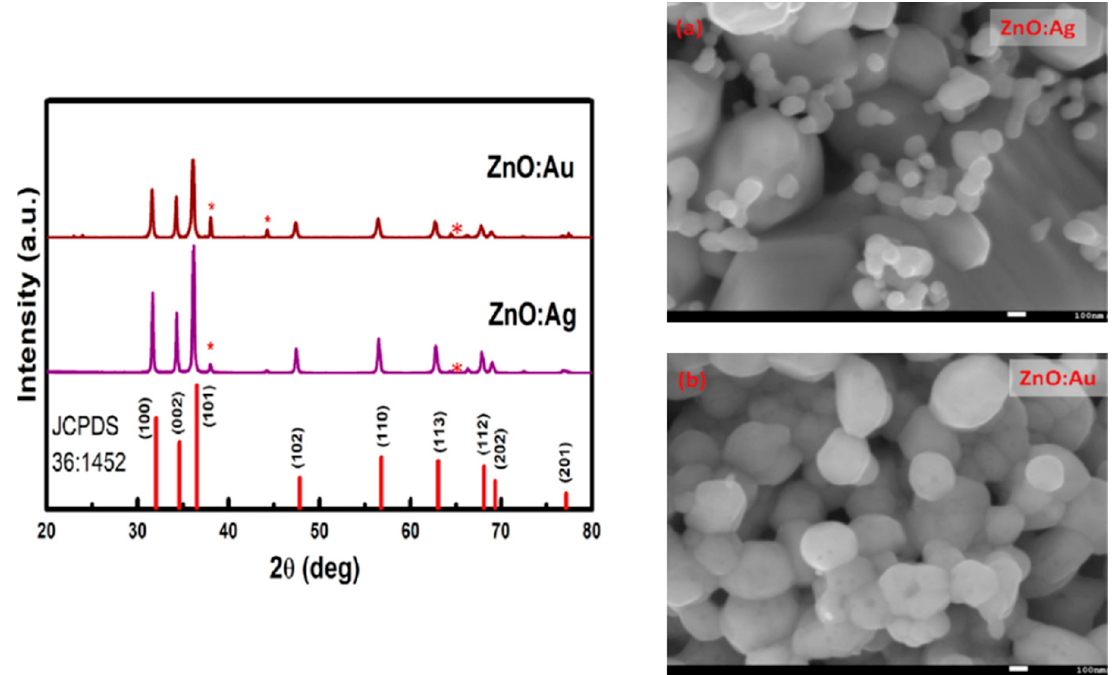
Figure 6. Au- and Ag-doped nanoparticles synthesized through a combustion method. On the left is the XRD patterns of the resulting particles, highlighting the presence of further peaks related to the secondary phases. On the right, the corresponding scanning electron microscope images of Ag-doped ( a ) and Au-doped ( b ) nanoparticles. Adapted from ref. [134] . ZnO was also doped with nickel by a solution combustion method. In the work of Silambarasan et al., zinc acetate, nickel (II) acetate, ethanol and ethylene glycol were mixed together and inflamed